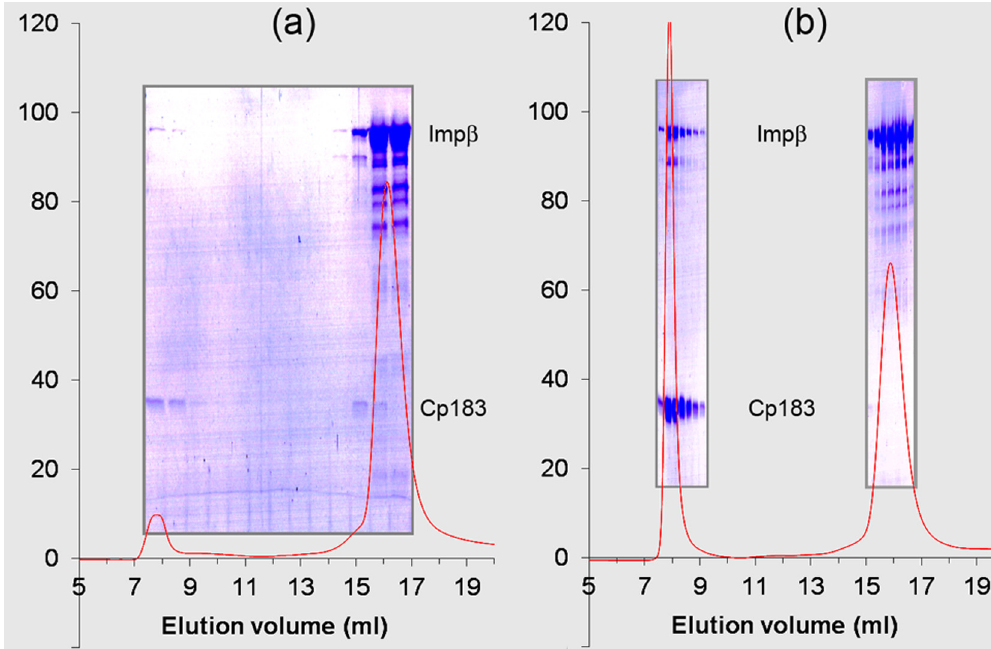
Fig 6. High concentrations of Imp β can lead to dissociation of HBV capsids. The fraction of Cp183 co-eluting with Imp β varies depending on the reaction conditions and the state of the Cp183. (a) 11 μ M Cp183 capsids with